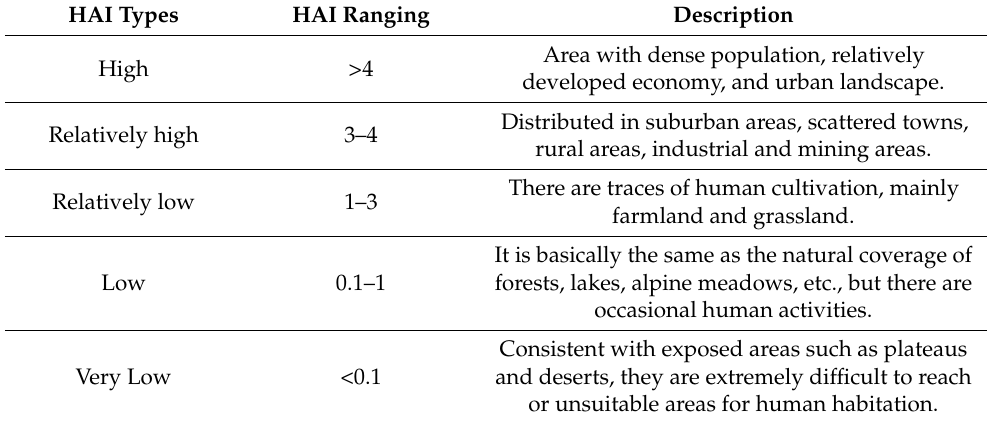
Table 2. The classification and description of HAI.